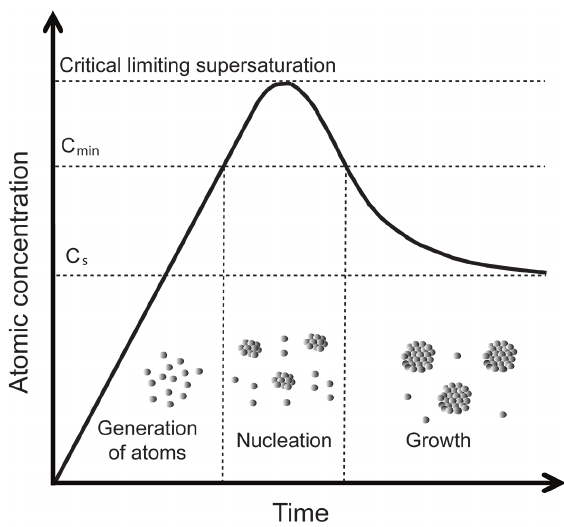
Figure 6 - Variations in the atomic concentration of growth species in solution as a function of time during the generation of atoms, nucleation, and growth stages. Adapted with permission from ref (Xia et al. 2009) Copyright 2009 Wiley-